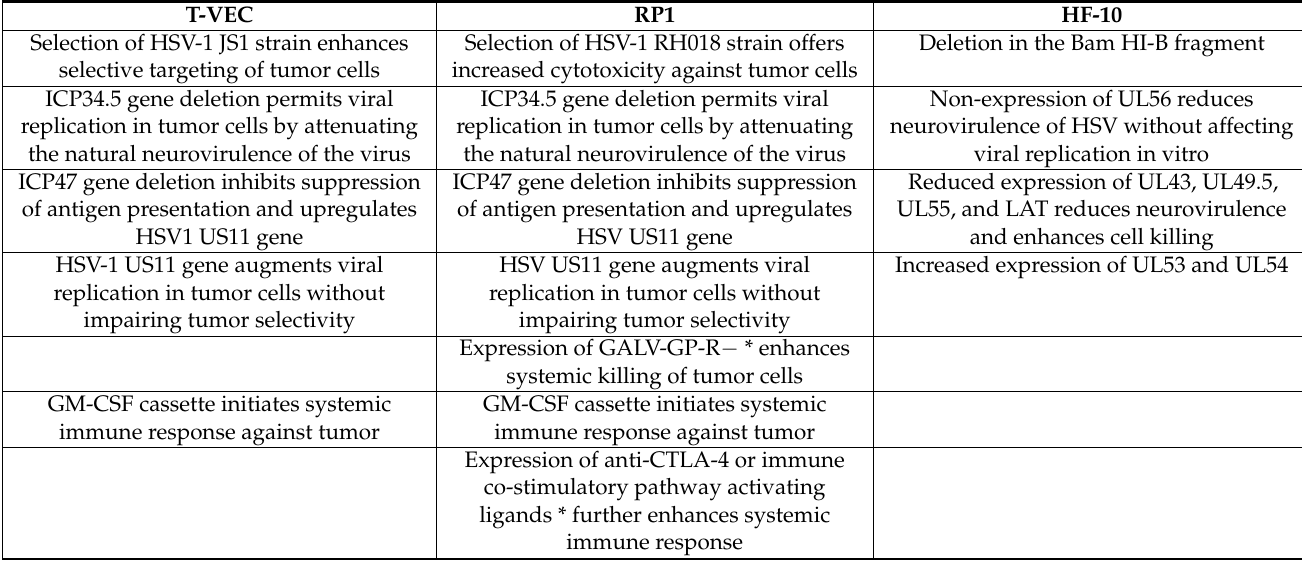
Summary of characteristics of studied oncolytic